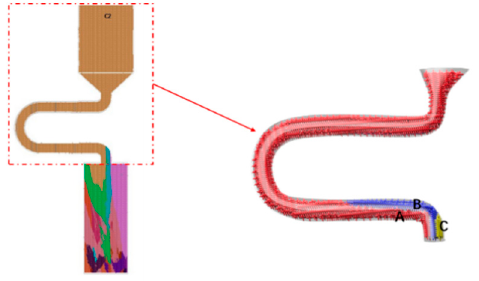
Figure 16. Simulation results in the selector parts of C 5 (d w = 3 mm, d s =20 mm).